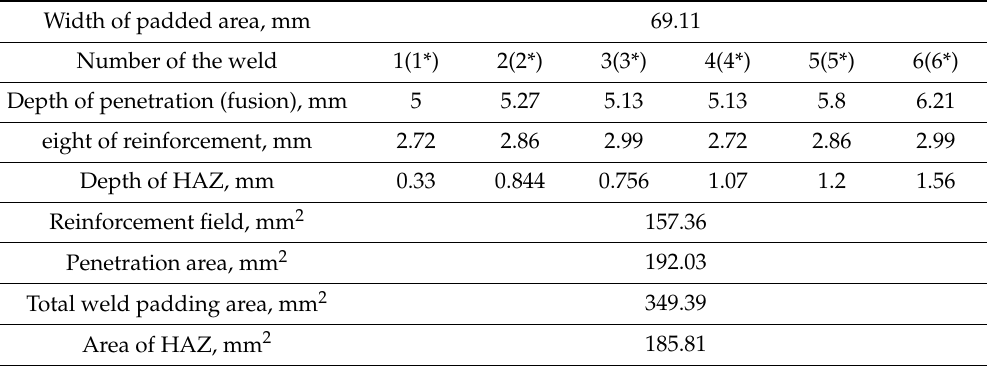
Table 1. The geometrical characteristics of the deposition zone in plate A.